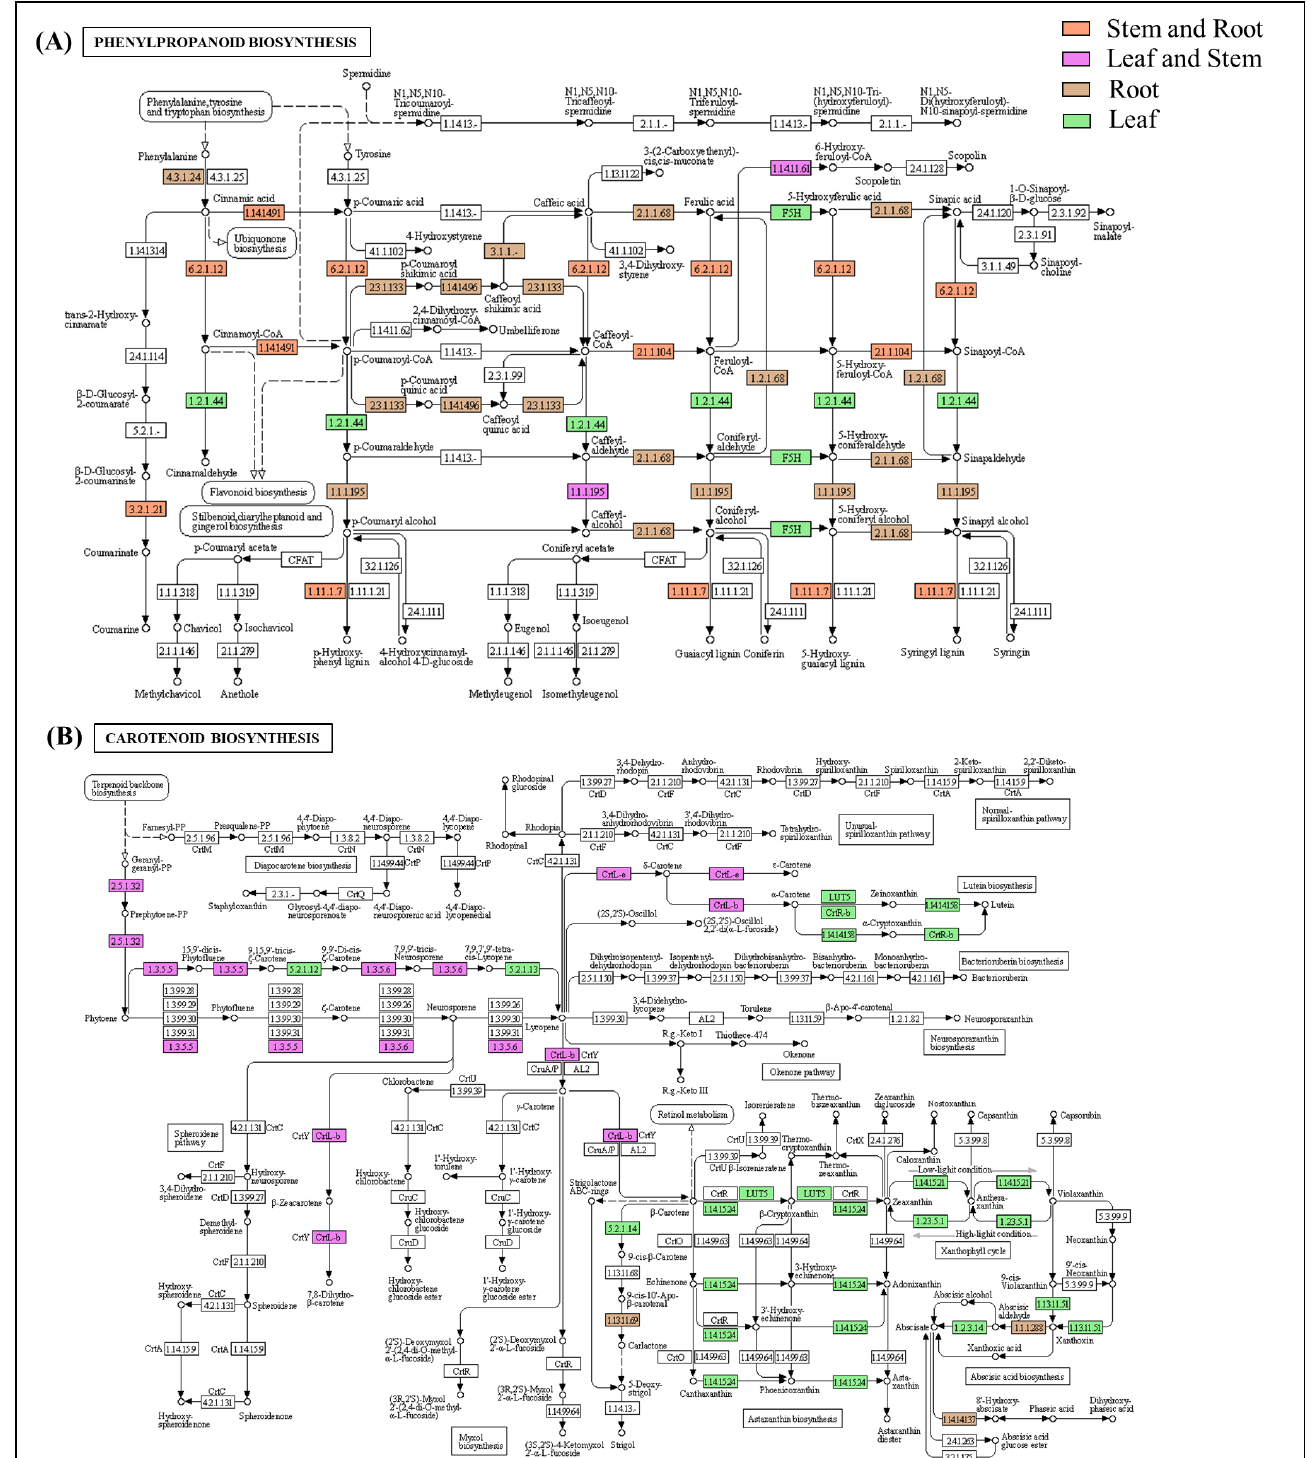
Figure 5. Representation of significant ( A ) phenylpropanoid- and ( B ) carotenoid-pathway enrichment in leaf, stem, and root tissues of A. glauca